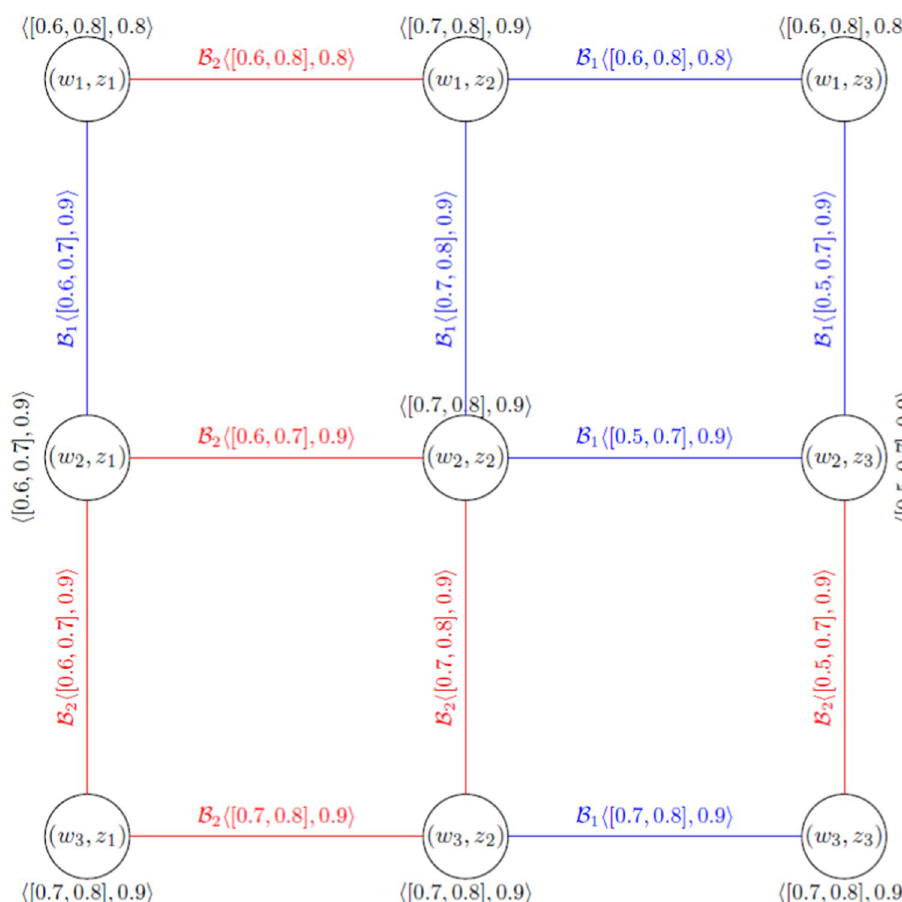
Fig. 13 The maximal product of two CFGSs G and G